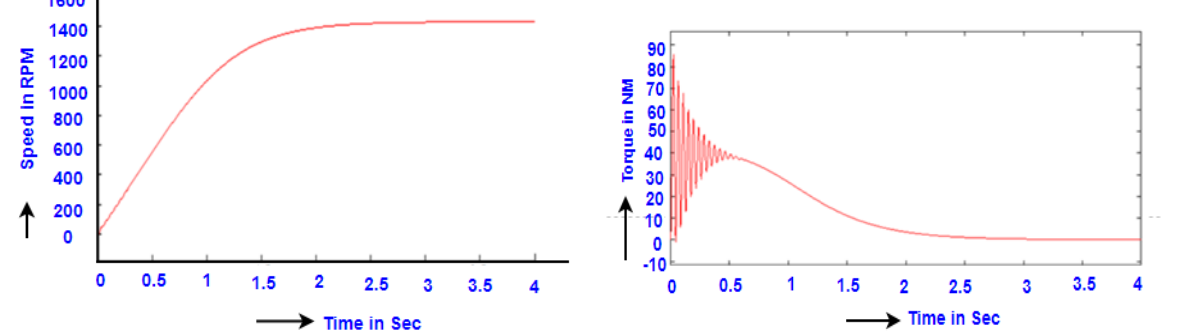
Figure 10. Stator current.